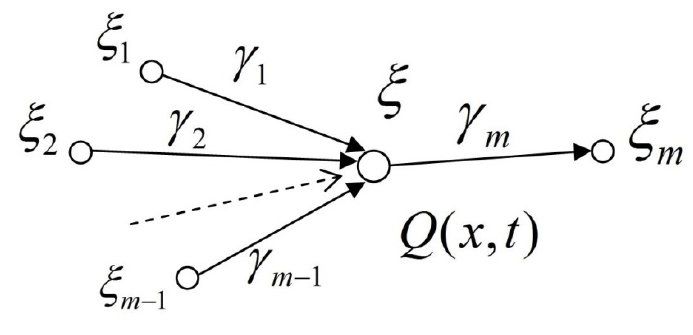
Figure 5. The star topology graph